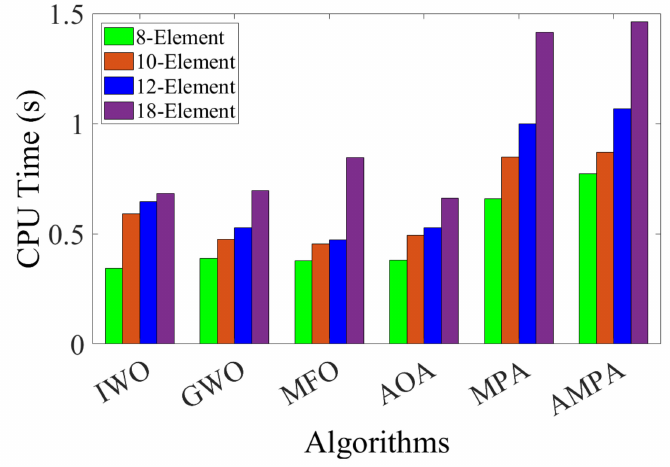
Figure 9. Bar graph for the computational time obtained by the algorithms for each CAA